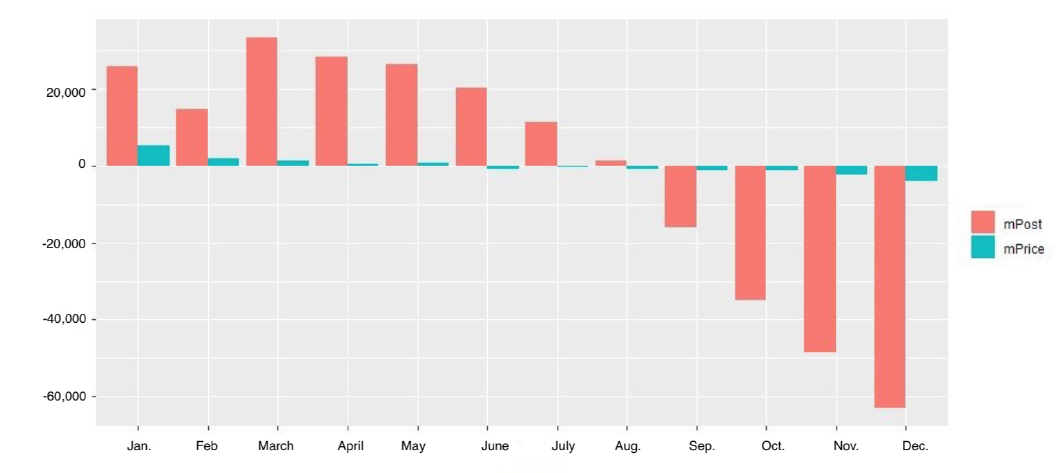
Figure 8. Variation of the monthly posts and the mean value of Bitcoin in